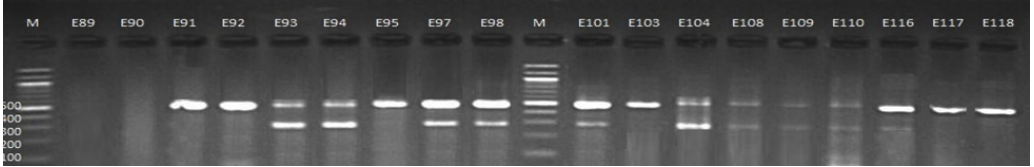
Fig. 2. 1.5% Agarose gel electrophoresis at 72 volt for 90 minutes of PCR to blaCTX-M-I amplicon (499bp) and blaCTX-M-III amplicon (305bp); lane M represent DNA marker size(100bp) while E89-E118 represent the isolates